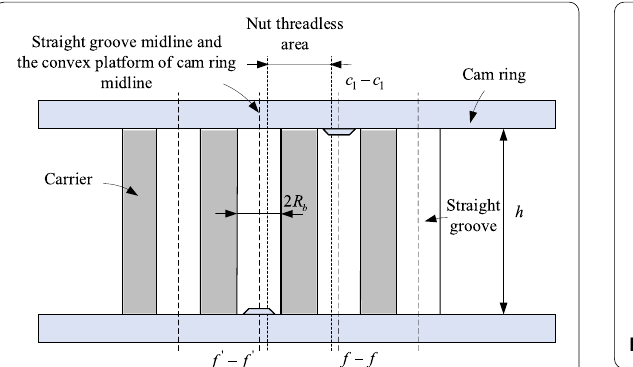
Figure 15 The assembly relation diagram of cam ring and carrier